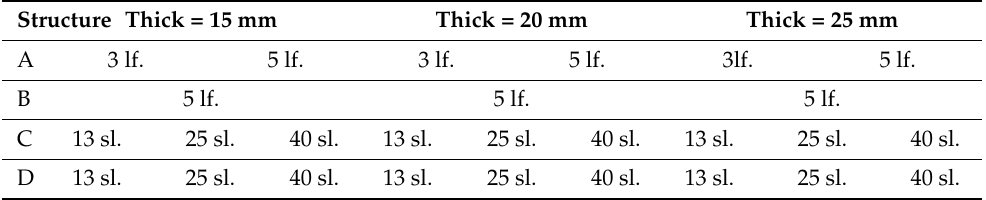
Table 1. All structures of experimental test (lf.—long friezes;